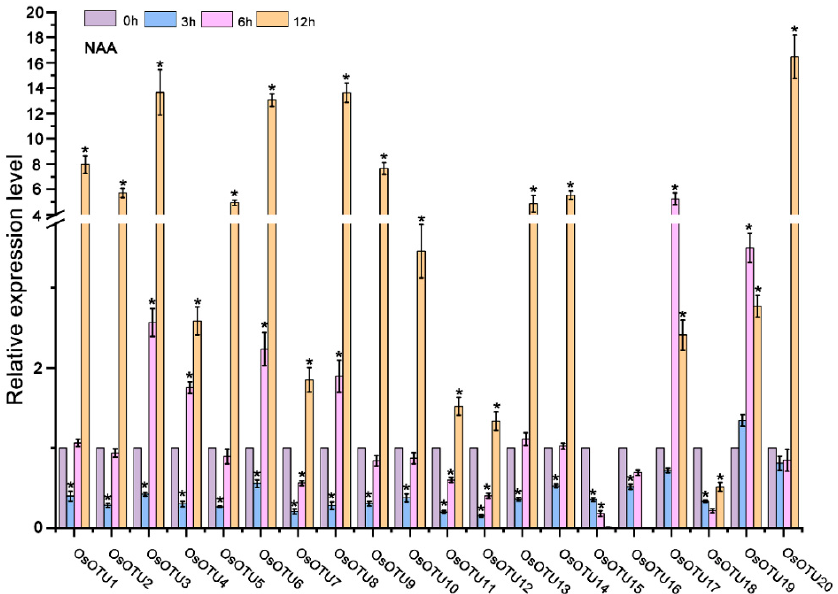
Figure 6. The expression pattern of OsOTU genes under different hormone treatments. Plants were treated with NAA (50 µ M). Samples were collected at 0, 3, 6, and 12 h. The OsUBQ5 gene was the reference gene used to calibrate the relative gene expression. Error bars represent ± SE ( n = 3). One-way analysis of variance was conducted by Duncan’s new multiple-range test, n = 3. * indicates significant differences from the mock control at p ≤ 0.05 by Fisher’s least significant difference tests.